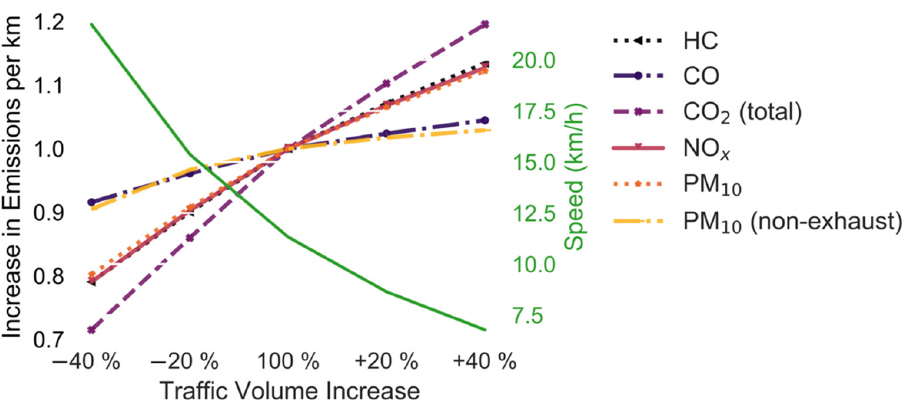
Figure 6. Increase in emissions per km (scenario 1) (HC, NO x , and PM10 are